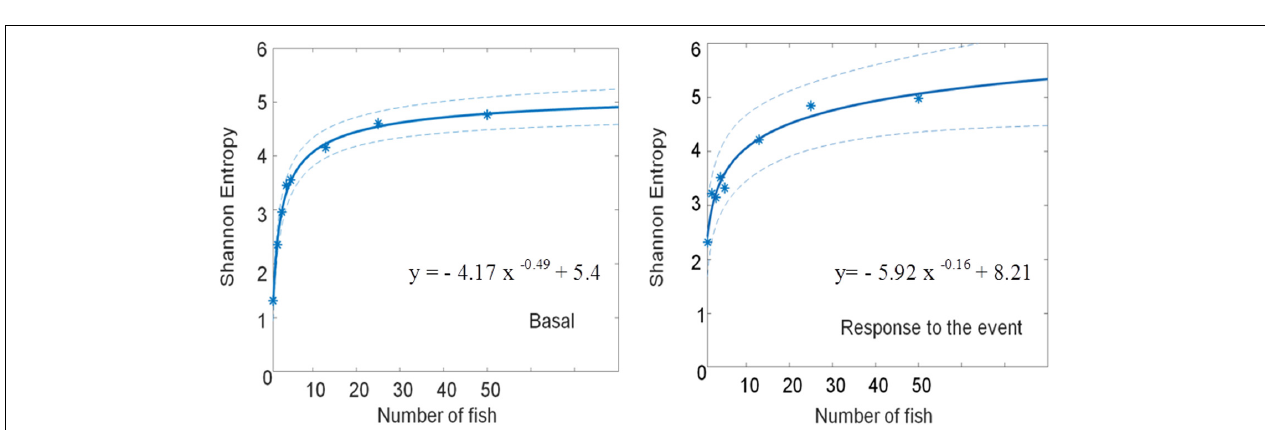
FIGURE 7 | Curve fitting of the Shannon entropy as a function of the fish number. The basal state (Left) and the response to the event (Right) are shown together with the 95% confidence bounds. The parameters of the curve fitting are shown in Table 5 .